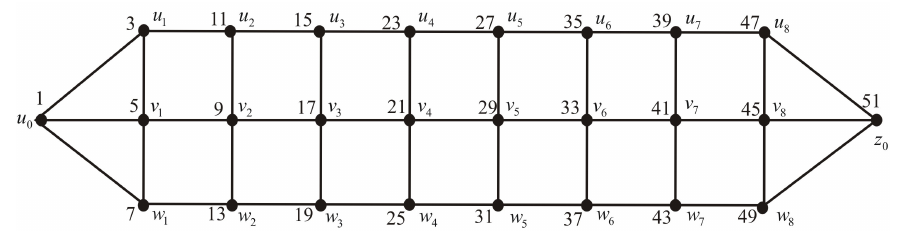
Figure 5: Arrow graph DA 3